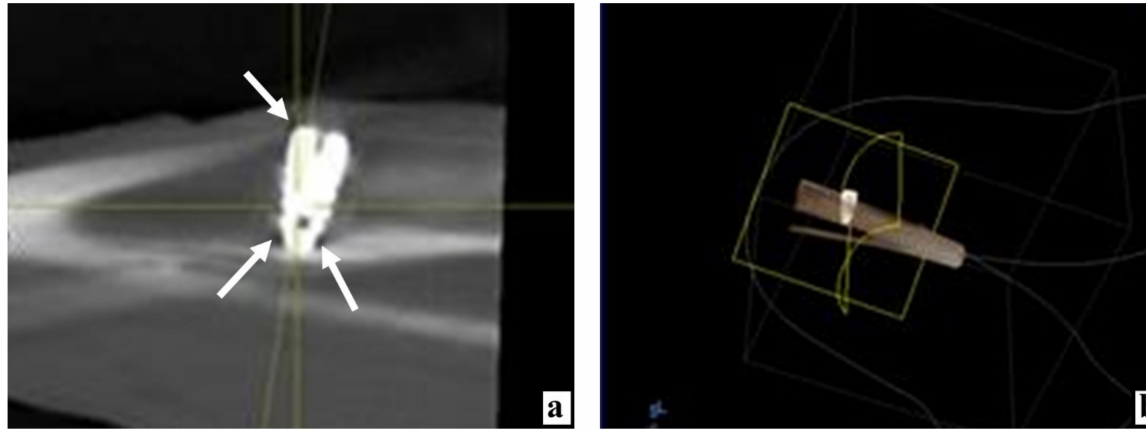
Figure 1. Results of studying the bone tissue of the proximal tibial condyle in control rabbits at various times after the introduction of dental implants. ( a ) X-ray image of the implant in the tibia 3 days after surgery, arrows indicate areas of reduced bone density. ( b ) Computer 3D modeling of the implant position in the bone on the 3rd day after surgery. ( c ) On the 3rd day after implantation, there are extensive hemorrhages and a large volume of split bone fragments in the cancellous bone, staining with hematoxylin and eosin. ( d ) Hemorrhages, vascular distention, and congestion (arrows) near and among the split bone particles 3 days after implant placement, stained with hematoxylin and eosin. ( e ) On the 10th day, the implant mostly borders with the bone tissue and only in small areas it is adjoined by loose fibrous connective tissue (arrows) with a significant number of hyperemic wide thin-walled vessels, stained with hematoxylin and eosin. ( f ) After 10 days the implant is delimited from the bone throughout its entire length by connective tissue with wide hyperemic vessels, stained with hematoxylin and